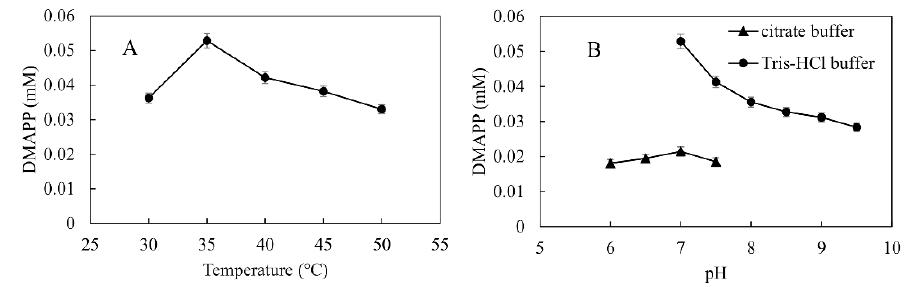
Figure 11. Optimization of conditions for the production of DMAPP via the one-pot enzymatic cascade: ( A ) Effect of temperature on DMAPP production. ( B ) Effect of pH on DMAPP production. ATP was an important cofactor for the synthesis of DMAPP [26,36]. The production of DMAPP increased linearly when the concentration of ATP increased from 1 to 10 mM,